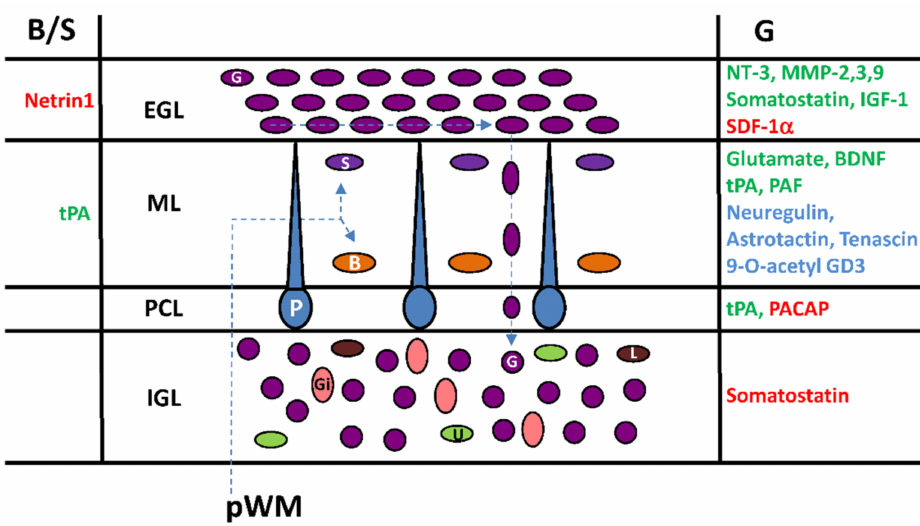
Figure 6. Multifactorial control of interneuron migration in the postnatal cerebellar cortex. Cortical-layer-specific effects of molecules that facilitate (in blue), stimulate (in green) or inhibit (in red) cell movements. pWM, prospective white matter; EGL, external granular layer; ML, molecular layer; PCL, Purkinje cell layer; IGL, internal granular layer; Gi, Golgi cell; U, unipolar brush cell; G, granule cell; L, Lugaro cell; P, Purkinje cell; B, basket cell; S, stellate cell; tPA, tissue-type plasminogen activator; PACAP: pituitary adenylate cyclase-activating polypeptide; NT-3, neurotrophin-3; MMP, matrix metalloproteinase; IGF-1, insulin growth factor-1; SDF-1 α , stromal cell-derived factor-1 α ; BDNF, brain-derived nerve factor; PAF, platelet-activating